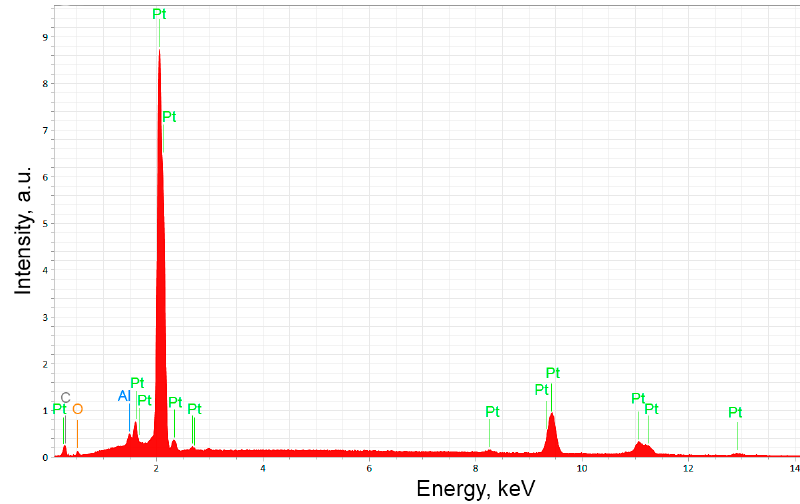
Figure 6. Scanning electron microscopy (SEM) image of the sintered line (dark grey central area) printed on alumina substrate (light grey lateral areas) ( A ) and the elemental mappings derived from the following EDX spectra: aluminum ( B ), platinum ( C ) and oxygen ( D ).